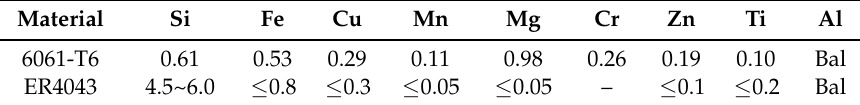
Table 1. Chemical components of the 6061-T6 alloy and the ER4043 welding wires.